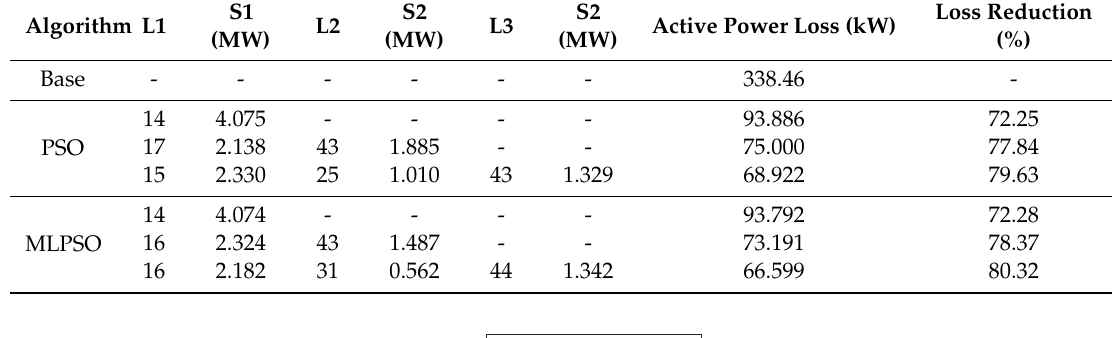
Simulations results of optimal placement and sizing of DGs for PSO, and MLPSO